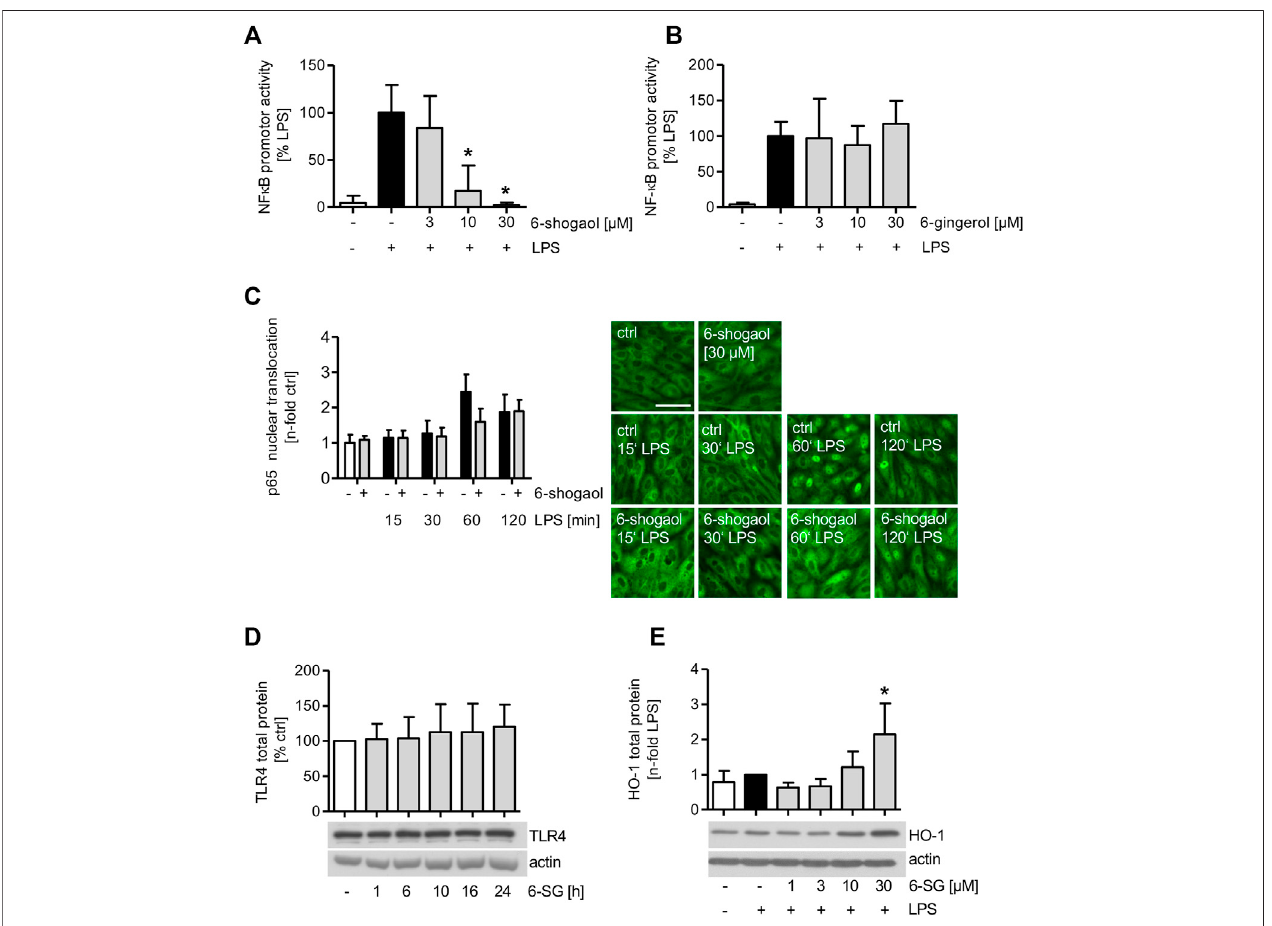
FIGURE3| LPS-inducedNF κ Bpromotoractivityisblockedby6-shogaolbutremainsunimpairedby6-gingerol. (A,B) 1×10 6 HUVECsperaluminumcuvettewere transiently transfected with a Renilla luciferase control plasmid pGL4.74[hRluc/TK] and fi re fl y luciferase reporter plasmid pGL4.32[luc2P/NF- κ B-RE/Hygro] using a Nucleofector 2b device. 24 h after transfection, the cells were treated with indicated concentrations of (A) 6-shogaol or (B) 6-gingerol for 6 h before NF κ B promotor activity was induced by LPS (1 μ g/ml) for an additional 4 h. NF κ B promotor activity was measured using a luminometer. (C) Con fl uent HUVECs were treated with 30 µM of 6-shogaol before the cells were activated with LPS (1 μ g/ml) for the indicated time points. Subsequently, the cells were stained for p65, and fl uorescence microscopy images were analyzed using ImageJ software. For each condition, one representative image out of four independently performed experiments is shown. Scale bar represents 50 µm. (D) Con fl uent HUVECs were treated with 30 µM of6-shogaol forindicated time points. Protein levels ofTLR4 were determined by Western blot analysis. Actin served as the loading control. One representative blot of four independently performed experiments is shown. (E) Con fl uent HUVECs were treated withindicatedincreasingconcentrationsof6-shogaolandwereinducedwithLPS(1 μ g/ml)for24 hbeforethesamplesweresubjectedtoWesternblotanalysisforHO-1 total protein. Actin served as the loading control. One representative Western blot is shown. 6-SG: 6-shogaol. Data are expressed as mean ± SD; (A,B) n = 3; * p ≤ 0.05 vs. LPS; (C,D) n = 4; (E) n = 5; * p ≤ 0.05 vs.